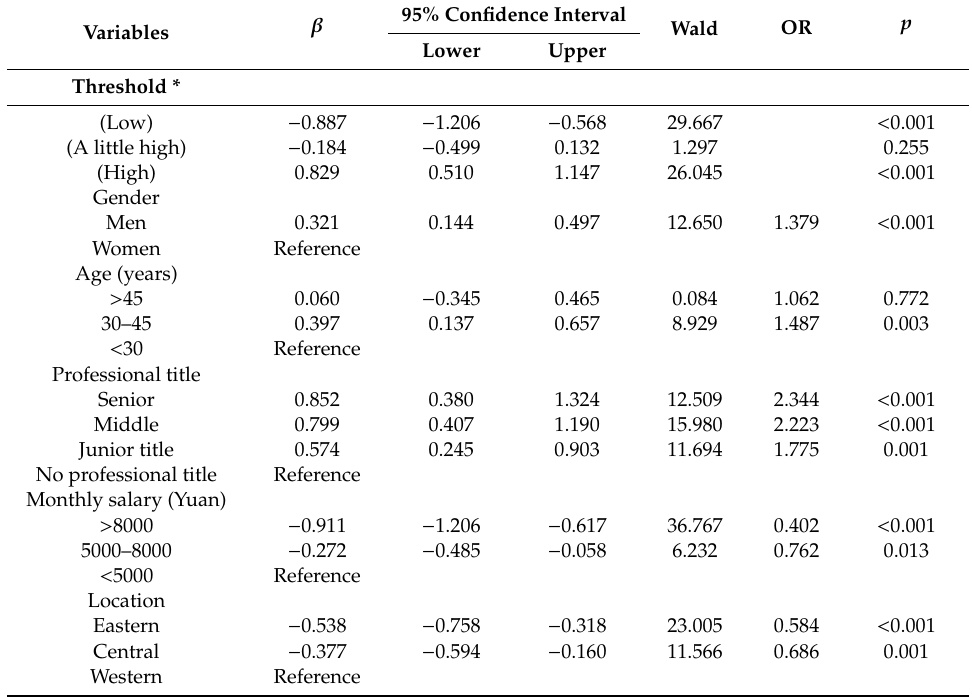
Table 5. Factors associated with work-related accumulated fatigue—results of ordinal logistic regression